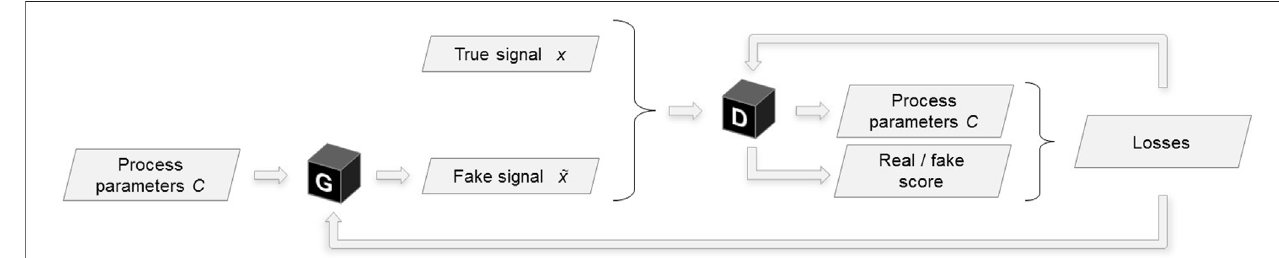
FIGURE 3 | Conditional GAN architecture. G denotes the generator network, D — the discriminator.